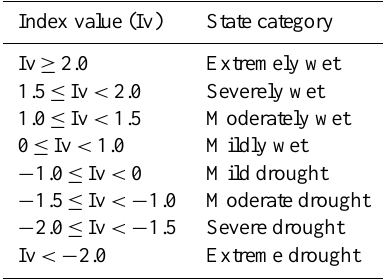
Table 3. State definition according to the index